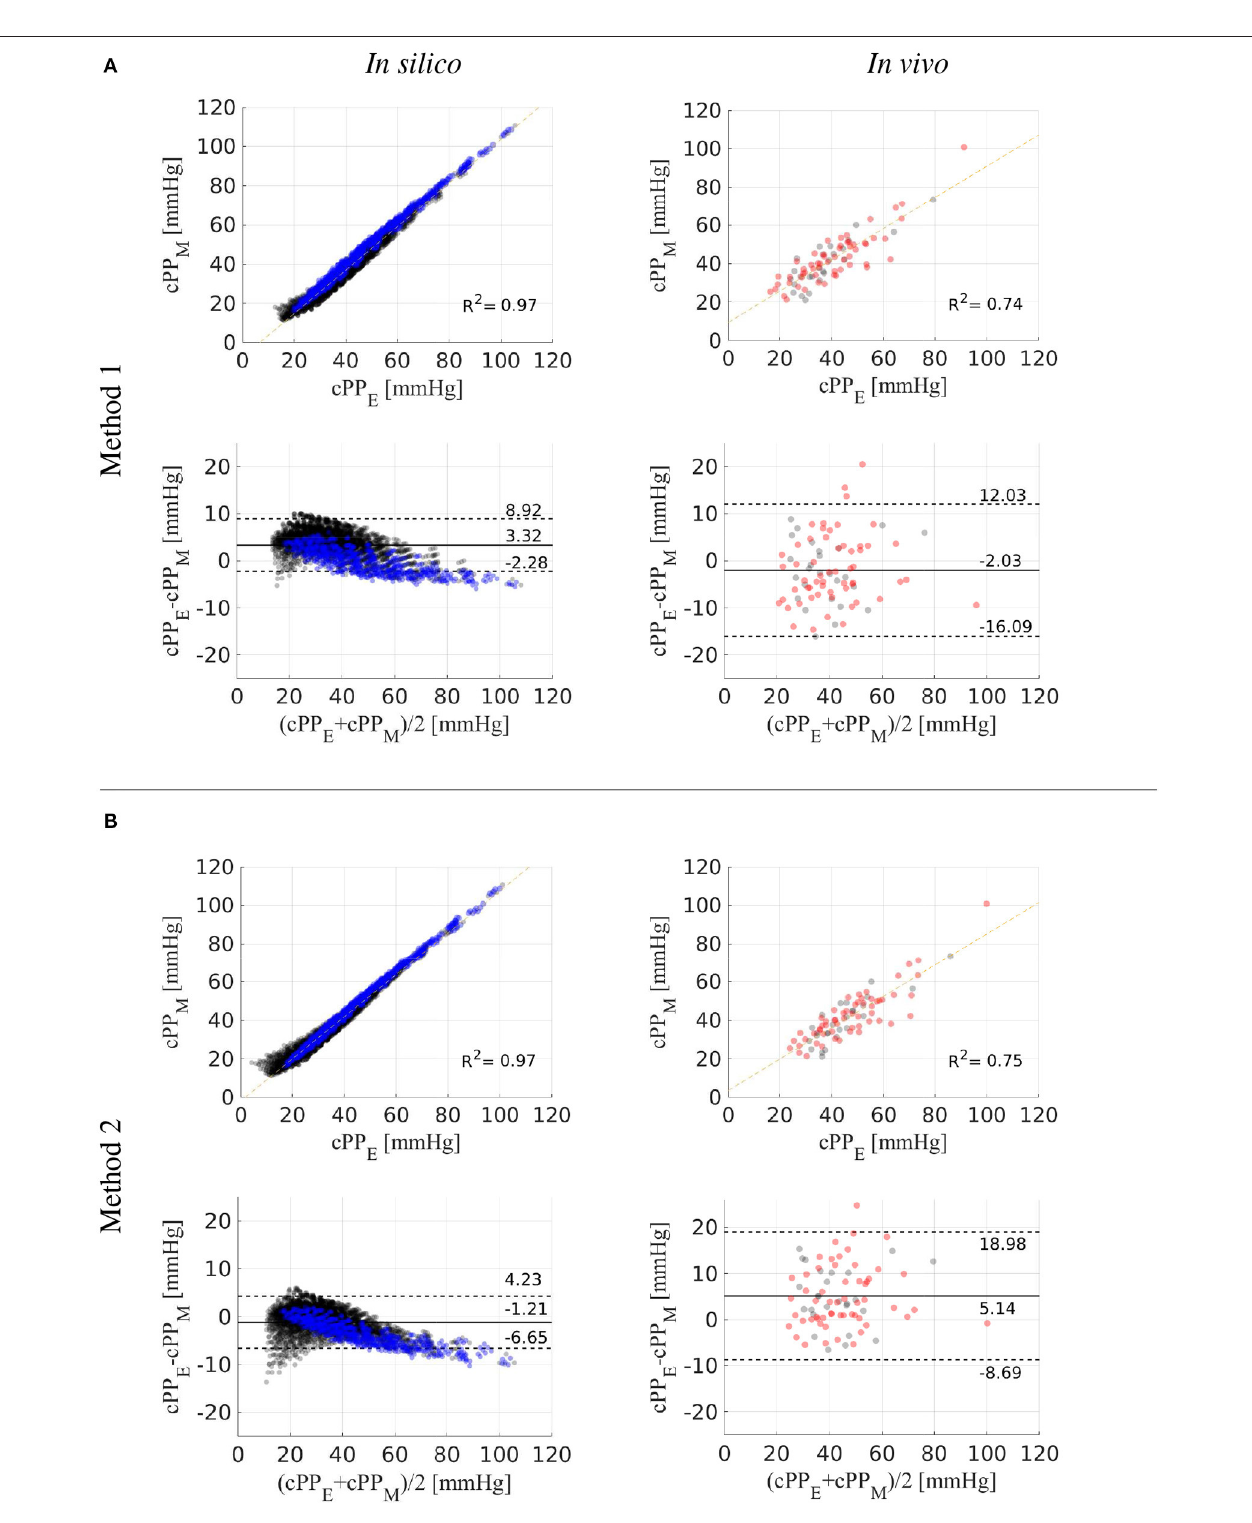
FIGURE 8 | Estimated (cPP E ) vs. measured (cPP M ) central pulse pressure. Correlation and Bland-Altman plots comparing cPP E values calculated using Methods 1 (A) and 2 (B) with (cPP M ) values for the in silico (left) and in vivo (right) datasets. In vitro 75-year-old subjects are shown in blue dots. In vivo hypertensive subjects are shown in red dots. Dotted horizontal lines show the limits of agreement ( ± 1.96 SD ) between estimated and reference cPP values.